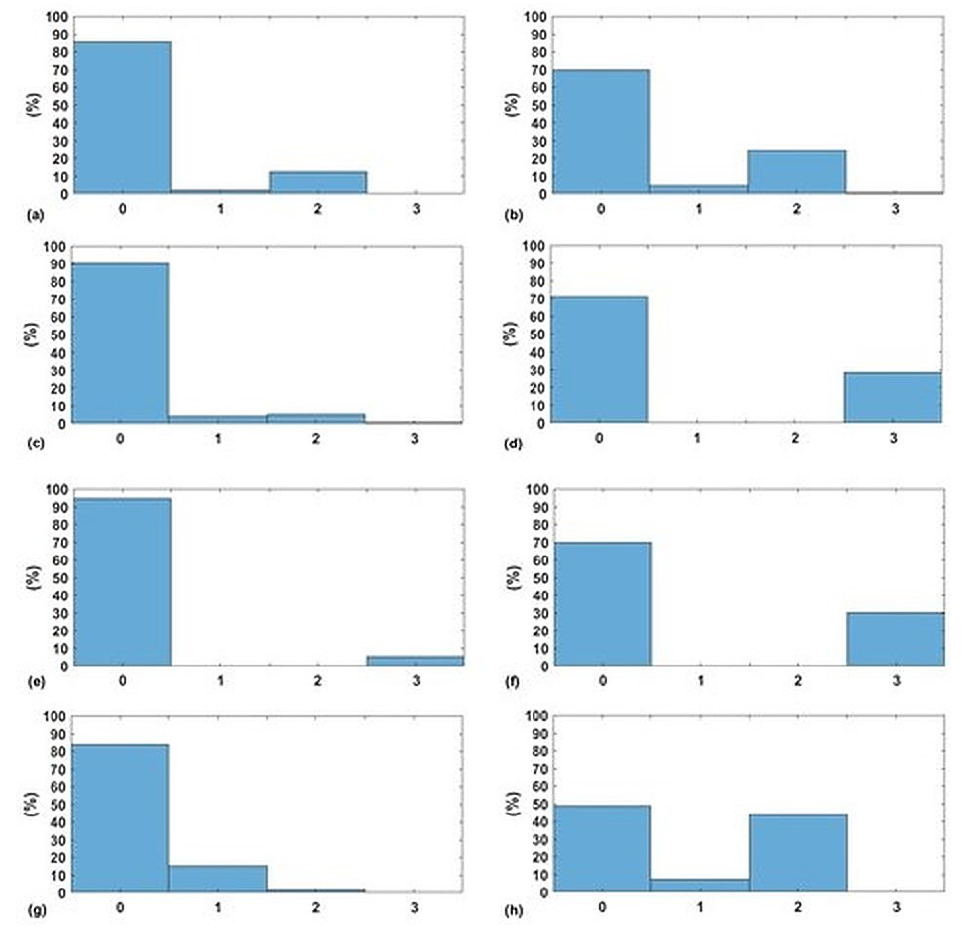
Figure 13. The normalised histogram of EWS components absolute error for both kNN-LS-SVM and Nieve predictors respectively of ( a , b ) HR, ( c , d ) SBP, ( e , f ) Sp O 2 , and ( g , h ) RR for Dialysis